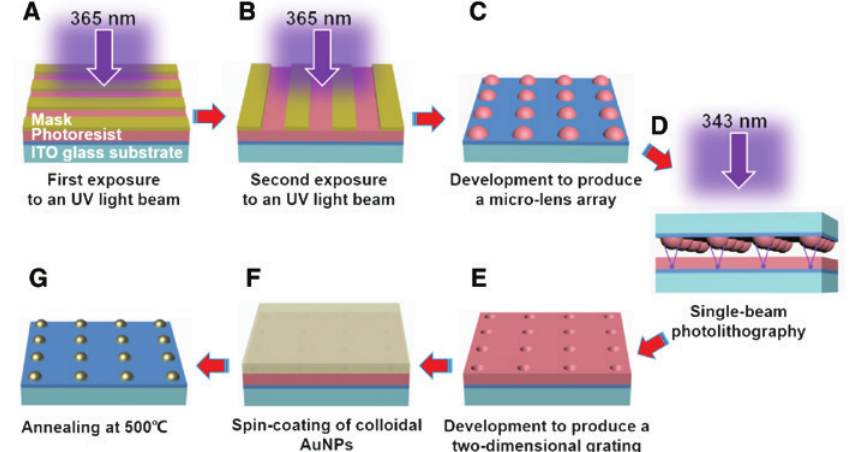
Figure 1: Procedures for constructing the microlens array and the plasmonic gratings via the intermediate single-beam photolithography. Fabrication procedures: (A and B) two-stage photolithography for the fabrication of a 2D MLA, (C) schematic illustration of the 2D MLA, (D) single-beam photolithography using MLAs, (E) schematic illustration of the 2D nanohole gratings, (F) spin coating of colloidal gold nanoparticles, and (G) annealing at 500 ° C to produce plasmonic gold